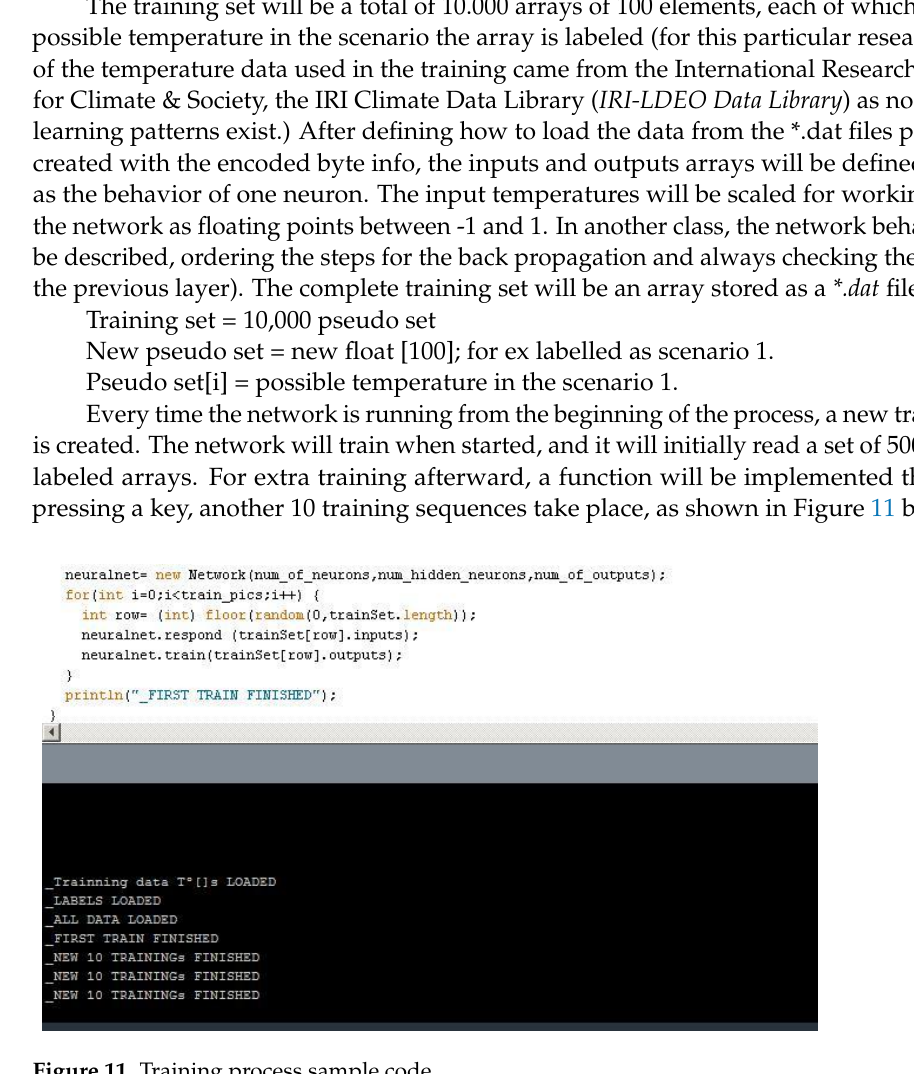
Figure 10. Learning cycle proposed.